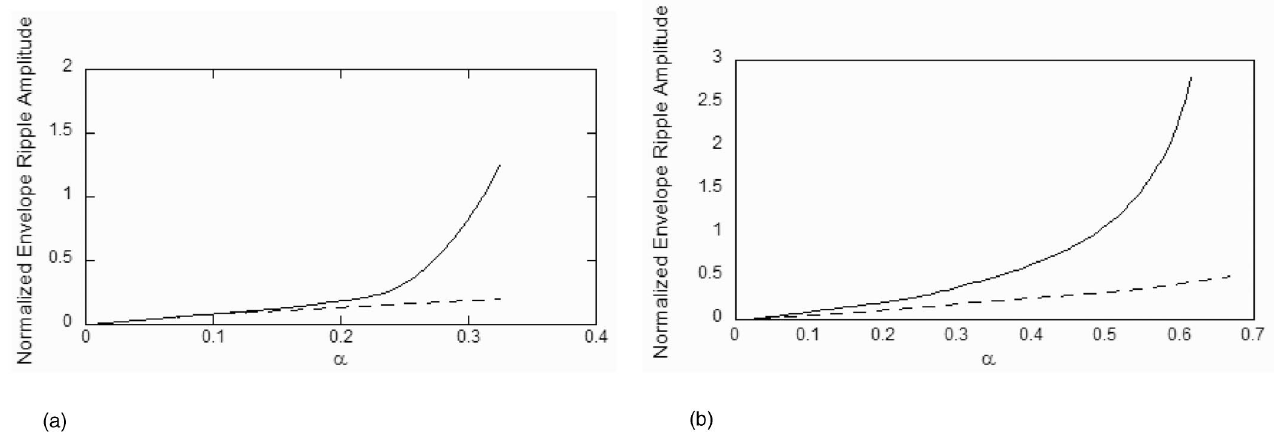
FIG. 1. Envelope ripple amplitude versus focusing period, solid line for emittance-dominated beam, dashed line for space-charge dominated beam. (a) Wiggler focusing. (b) PPM